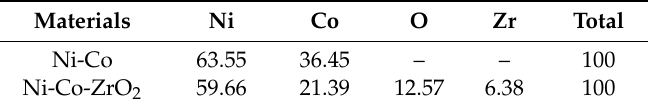
Figure 9. Scanning electron microscope (SEM) images for the coatings: ( a ) Pure copper plate; ( b ) nano-ZrO 2 particles; ( c ) Ni-Co layer; ( d ) Ni-Co layer; ( e )Ni-Co-ZrO 2 multiple coating; ( f ) Ni-Co-ZrO 2 multiple coatings. Table 4. Atomic percentage of each element in the coatings (wt